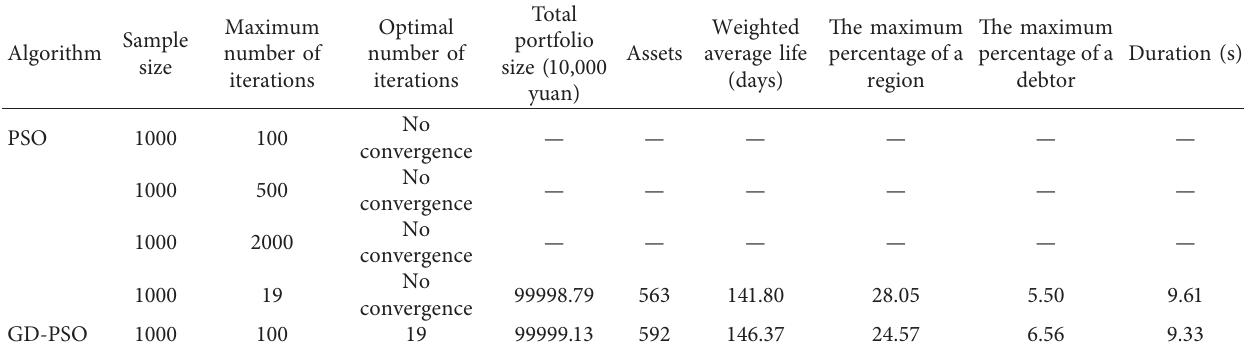
Table 2: Comparison of GD-PSO and PSO algorithm results.